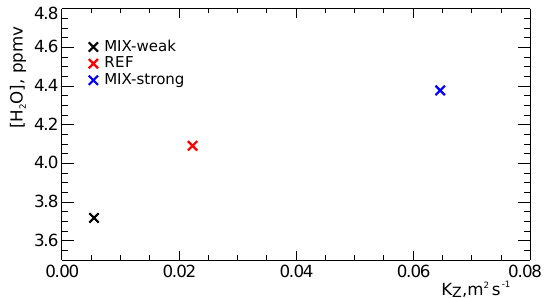
Figure 19. Water vapour as a function of the average vertical diffu- sivity coefficient ( K z ) in the simulations with different small-scale mixing strength. The data are annual mean values spatially aver- aged over the 380 to 420K potential temperature and 20 ◦ S–20 ◦ N latitude region from different sensitivity simulations with respect to small-scale mixing (for 2011). Black cross represents weak mix- ing (MIX-weak, λ c = 2day − 1 ), red cross shows reference (REF, λ c = 1 . 5day − 1 ) and blue cross represents strong mixing (MIX- strong, λ c = 1day − 1 )